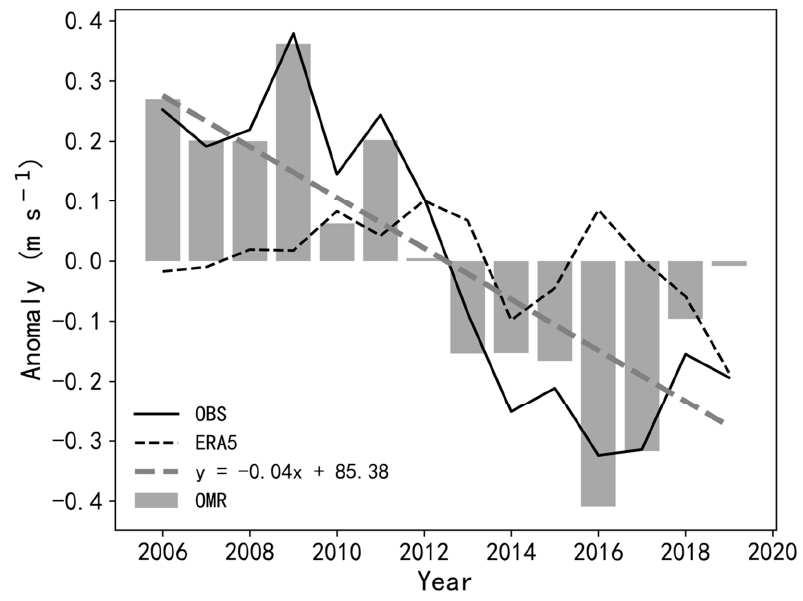
Figure 5. Inter-annual variations of SWS (m s − 1 ) averaged over Zhuhai from anomalies of observa- tions (OBS) and reanalysis (ERA5), as well as from OMR methods.